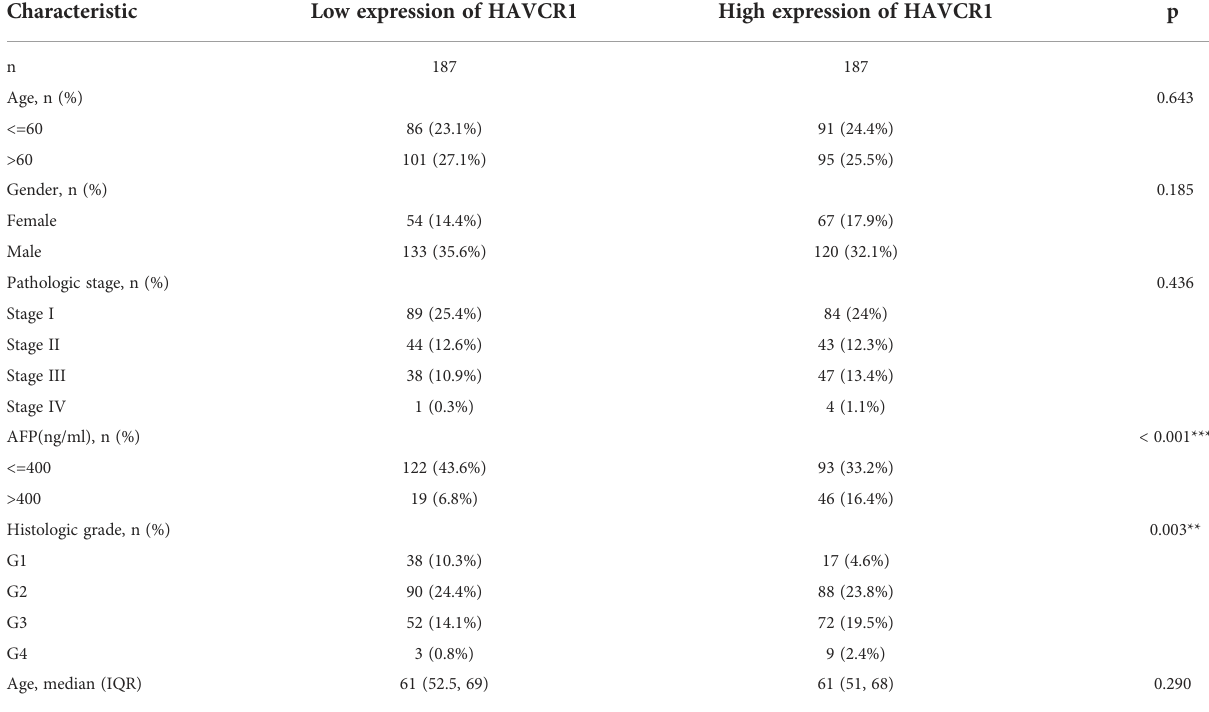
TABLE 4 Association of HAVCR1 expression with clinicopathological parameters in TCGA-LIHC.